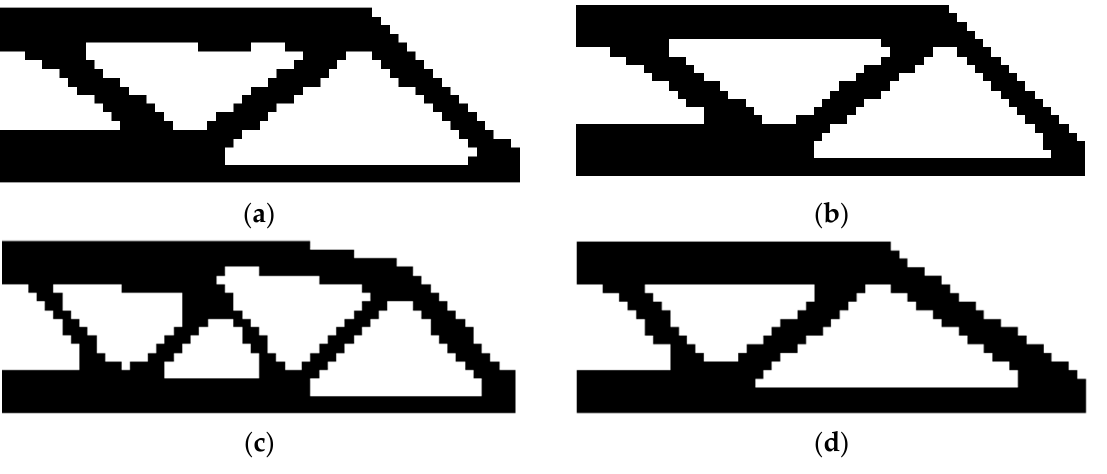
Figure 3. Optimal topology for the Michell-type structure. ( a ) C = 94.4720, t = 63. ( b ) C = 95.6902, t = 60. ( c ) C = 96.0235, t = 57. ( d ) C = 96.6927, t = 56.